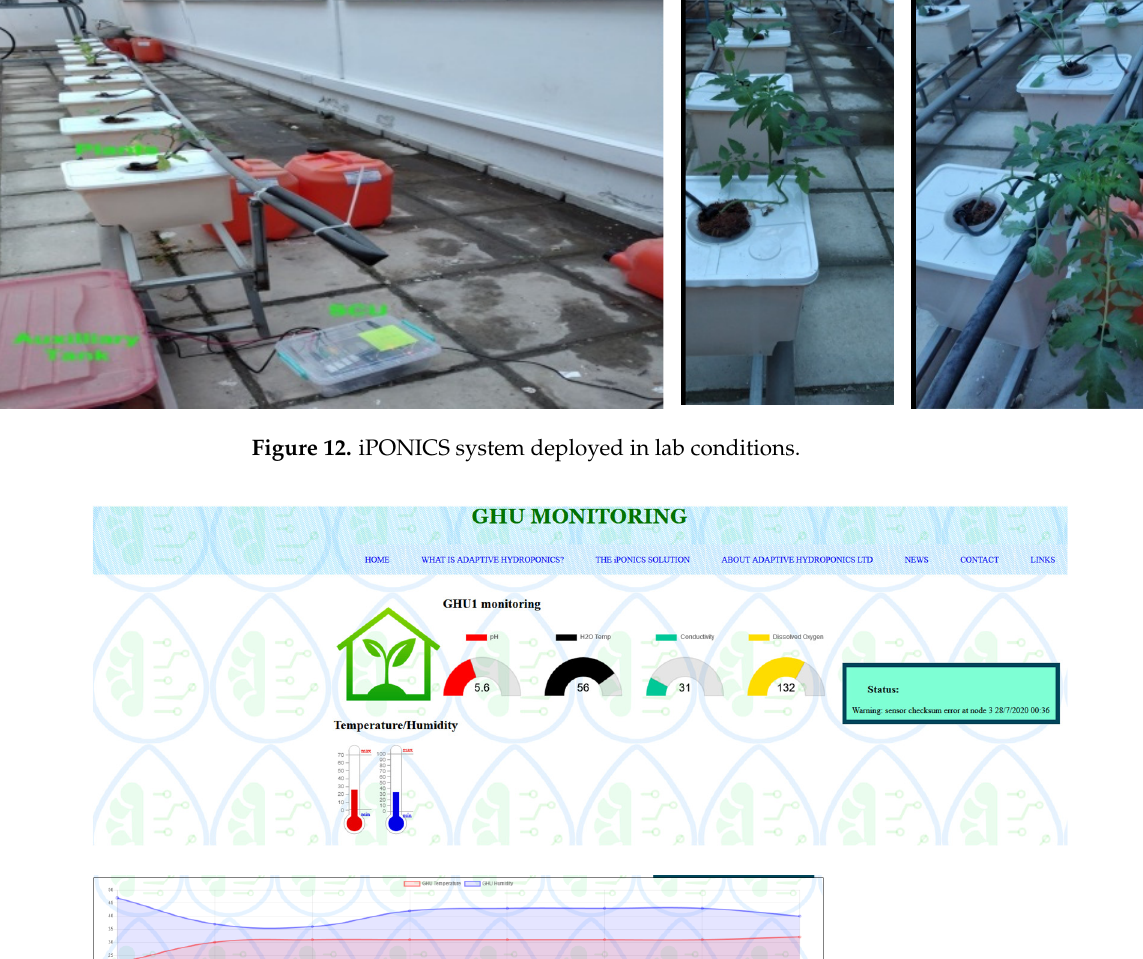
Figure 13. iPONICS monitoring page.